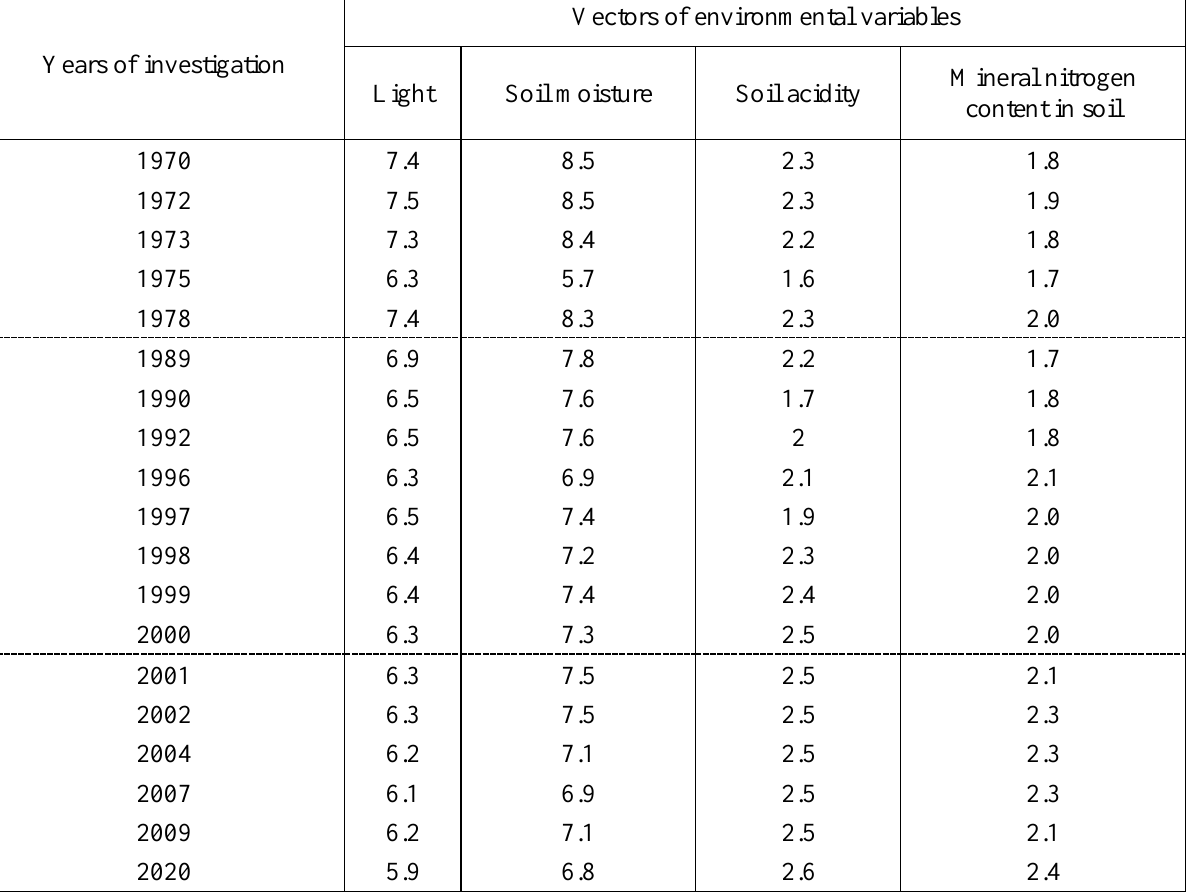
Table 1. The basic environmental factors for vegetation communities of meso-oligotrophic dwarf shrub- Sphagnum pine stand resulting from the 50 years research (Ellenberg’s indicator values). The dotted lines indicate the transitions between Drainage Periods (Figure